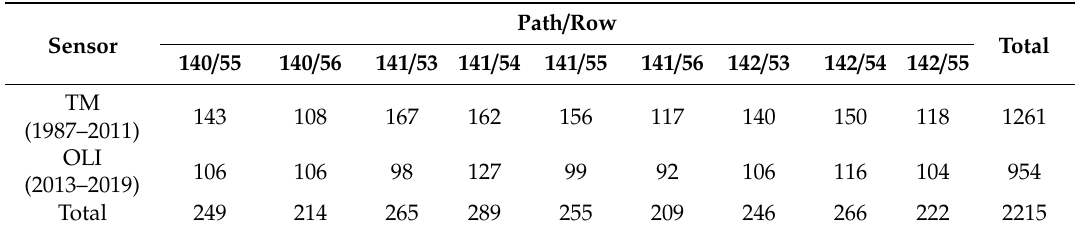
Table 1. The number of Landsat Thematic Mapper (TM) and Operational Land Imager (OLI) images used per path / row in this